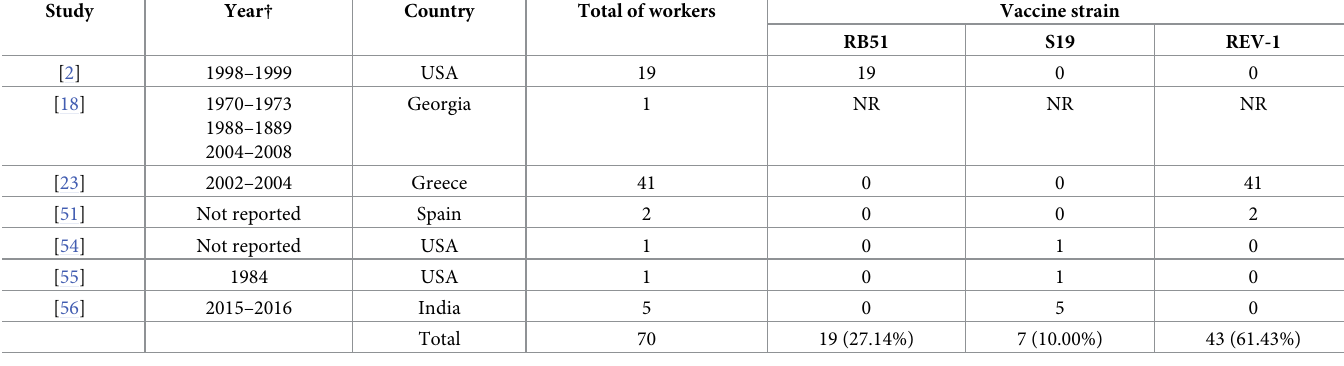
Table 3. Adverse events or occupational brucellosis in veterinarians and veterinary assistants associated with accidental exposure to anti- Brucella spp. live attenu- ated vaccines.